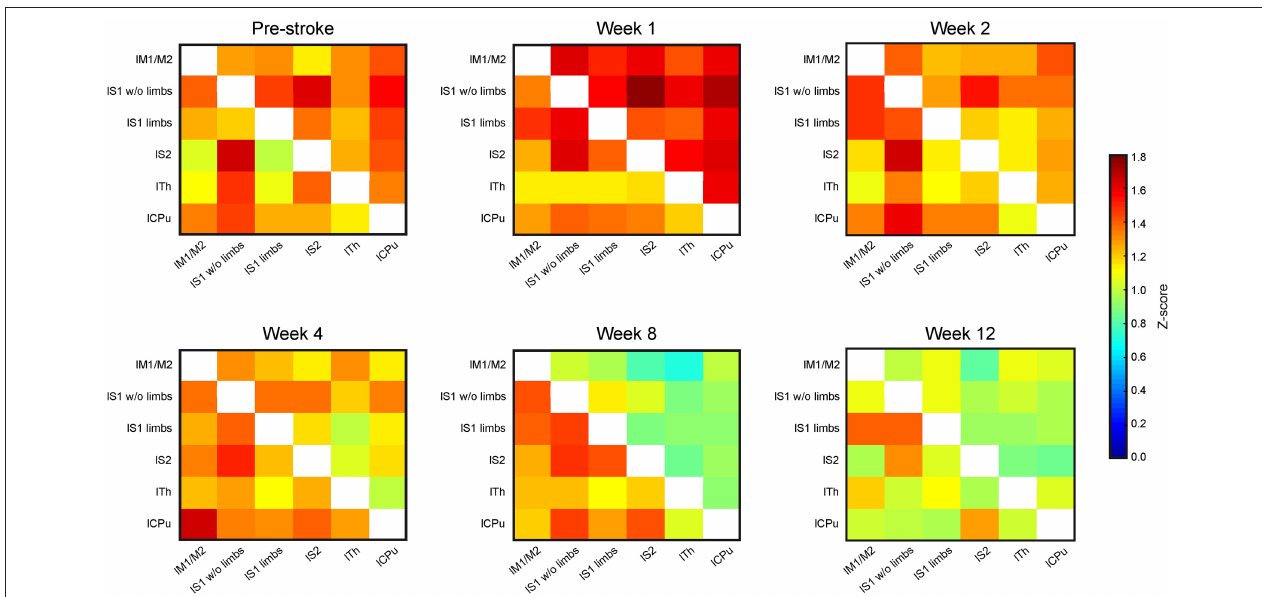
FIGURE 4 | Connectivity matrices of the contralesional hemisphere over 3 months. The connectivity matrix of the contralateral hemisphere for the cortico-striatal group in the upper triangle, and for the striatal group in the lower triangle, with data presented for pre-stroke, weeks 1, 2, 4, 8, and 12 post stroke induction and neural stem cell implantation. The z -score values of the sensorimotor functional network of the cortico-striatal lesion group present a connectivity decrease, being substantial from week 4 on, and reaching its minimum at week 8. In the striatal lesion group, z -score values remain without clear changes to the pre-stroke situation during the first 8 weeks. Only at the last time point, at week 12 post implantation, the connectivity values decrease approximating those of the cortico-striatal